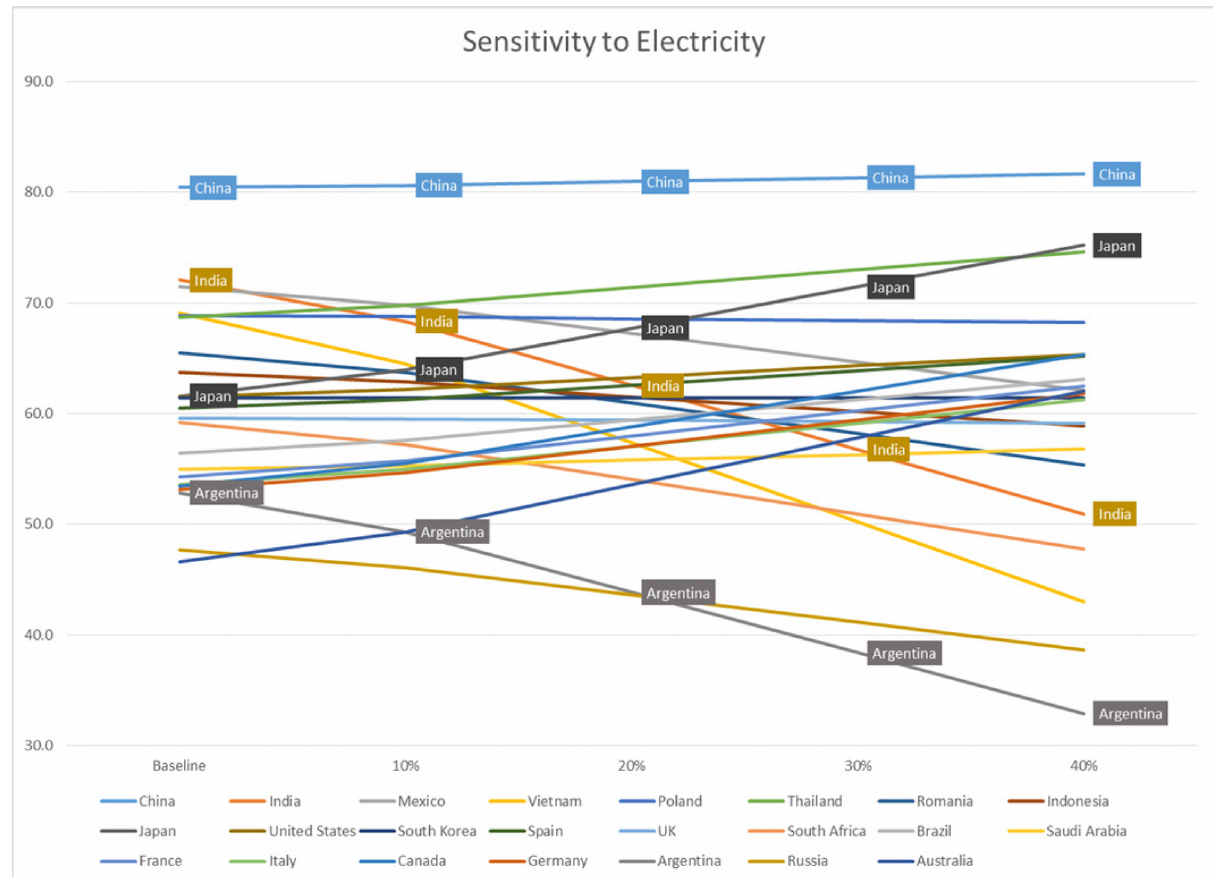
Figure 7. Electricity index utility weight